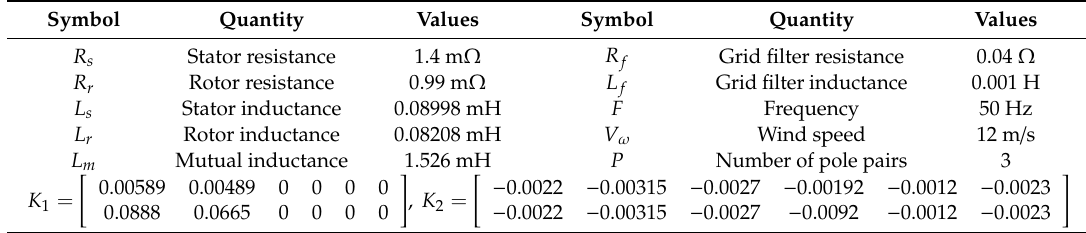
Table 1. 1.5 MW system